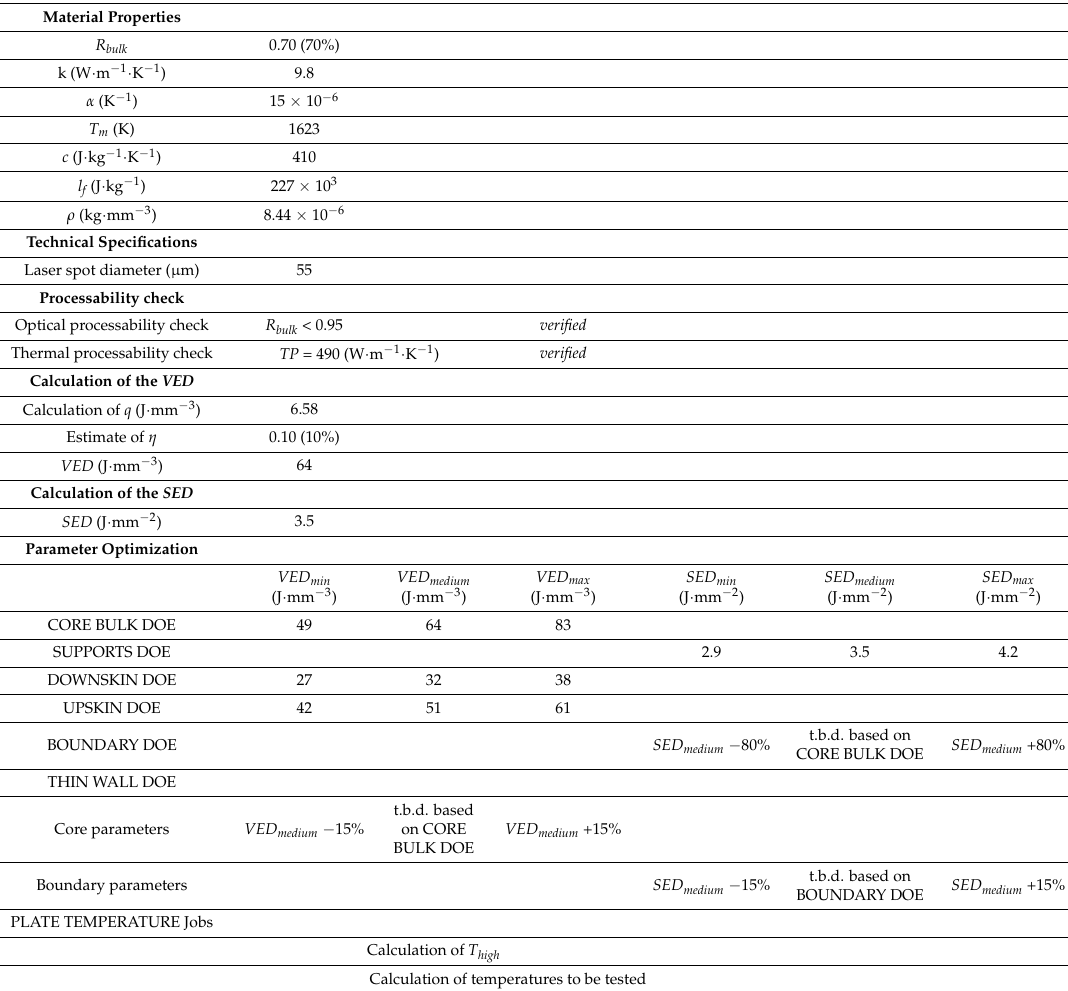
and surface energy density (SED) values and related variation ranges. DOE, design of